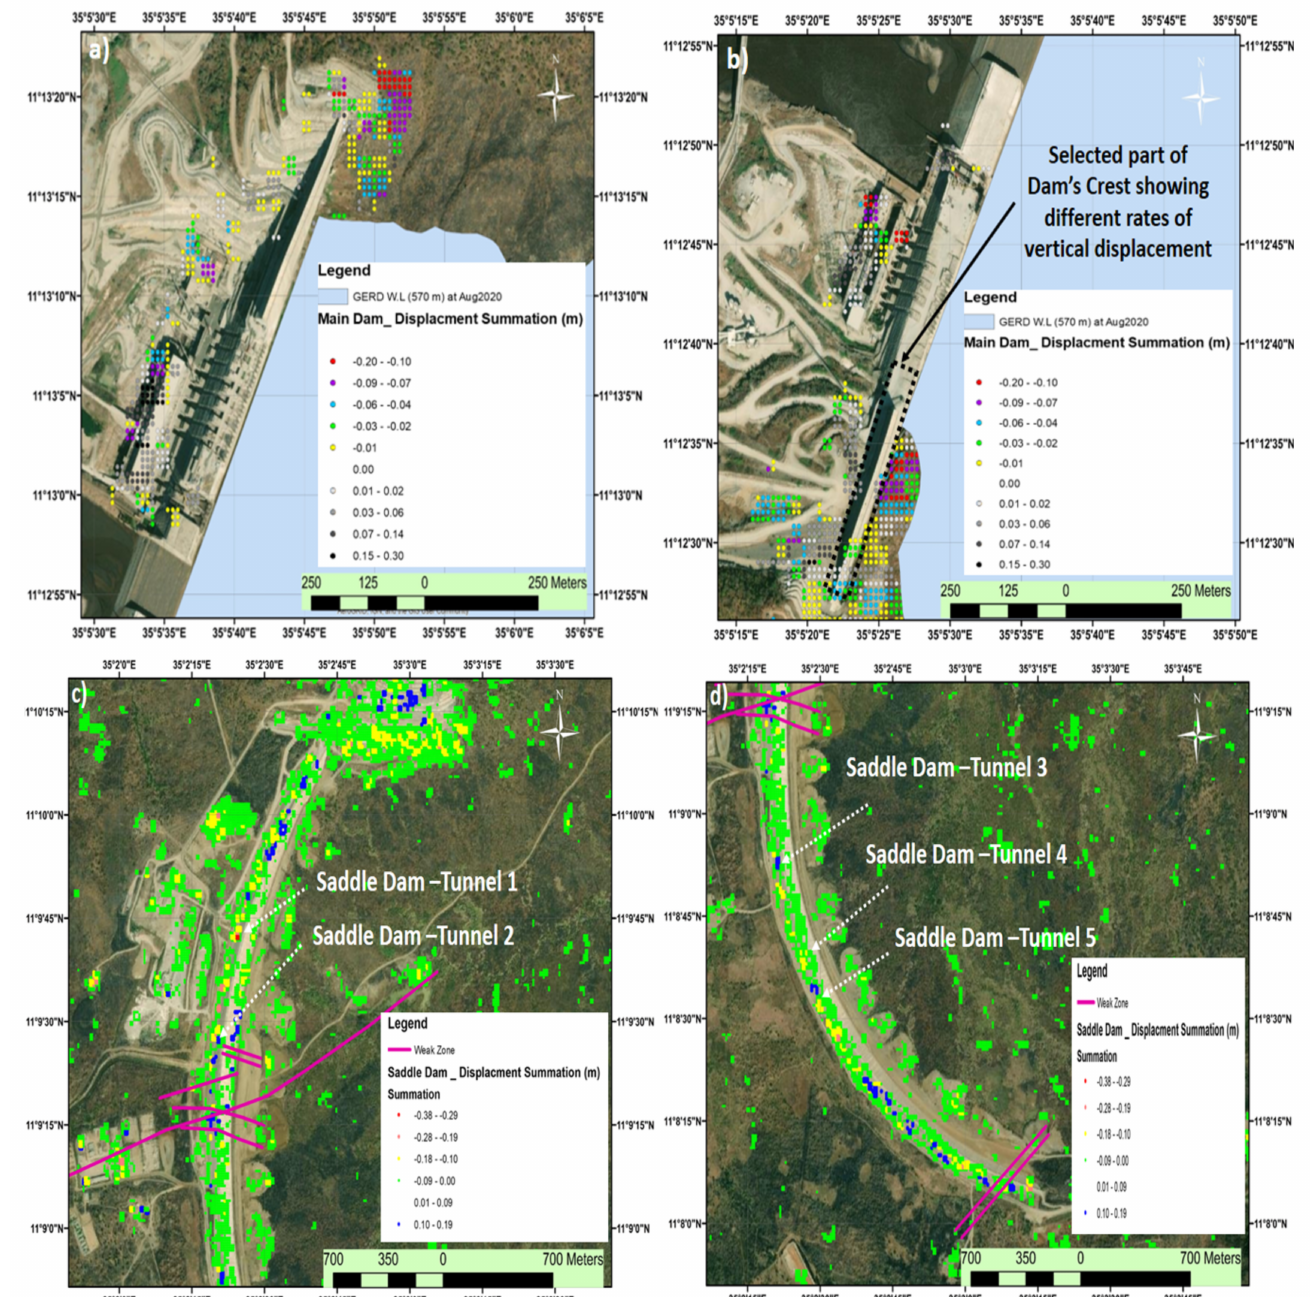
Figure 7. DInSAR displacement spatially observed over the GERD’s Main Dam ( a , b ) and Saddle Dam ( c , d